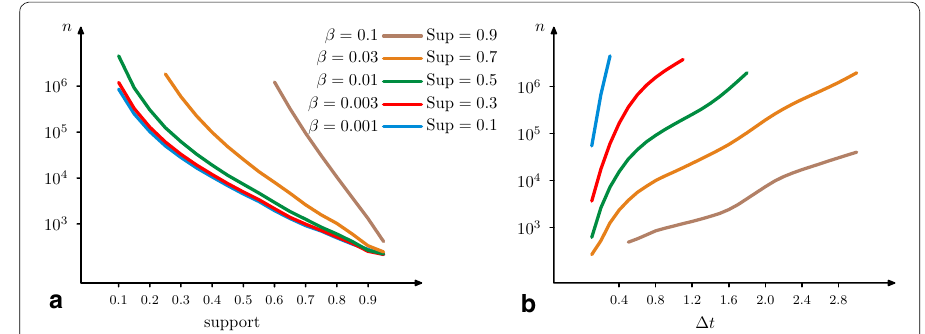
Fig. 10 The number of patterns found for the weather dataset with additional time restrictions. a (cid:31) t = 0.3 , b β = 0.01